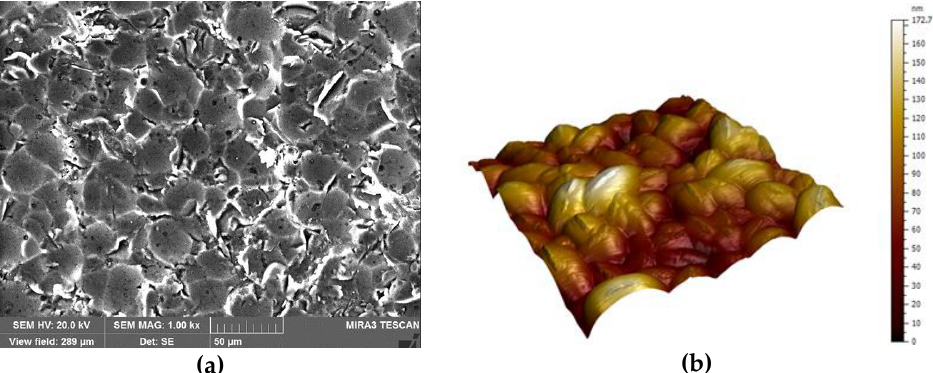
Figure 2. ( a ) SEM image of the micro-roughed surface (SE, 1 kx), ( b ) AFM image of the nanostructure (1 μm × 1μm) tapping mode, 3D rendering.